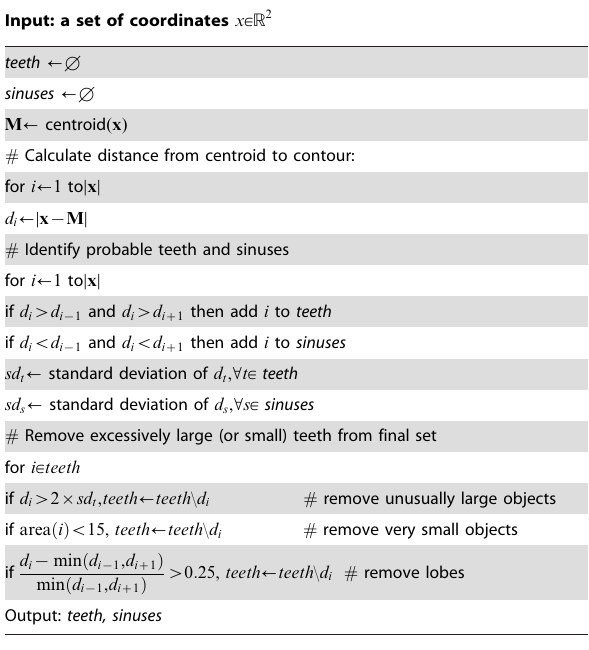
Table 1. Outline of algorithm for tooth finding